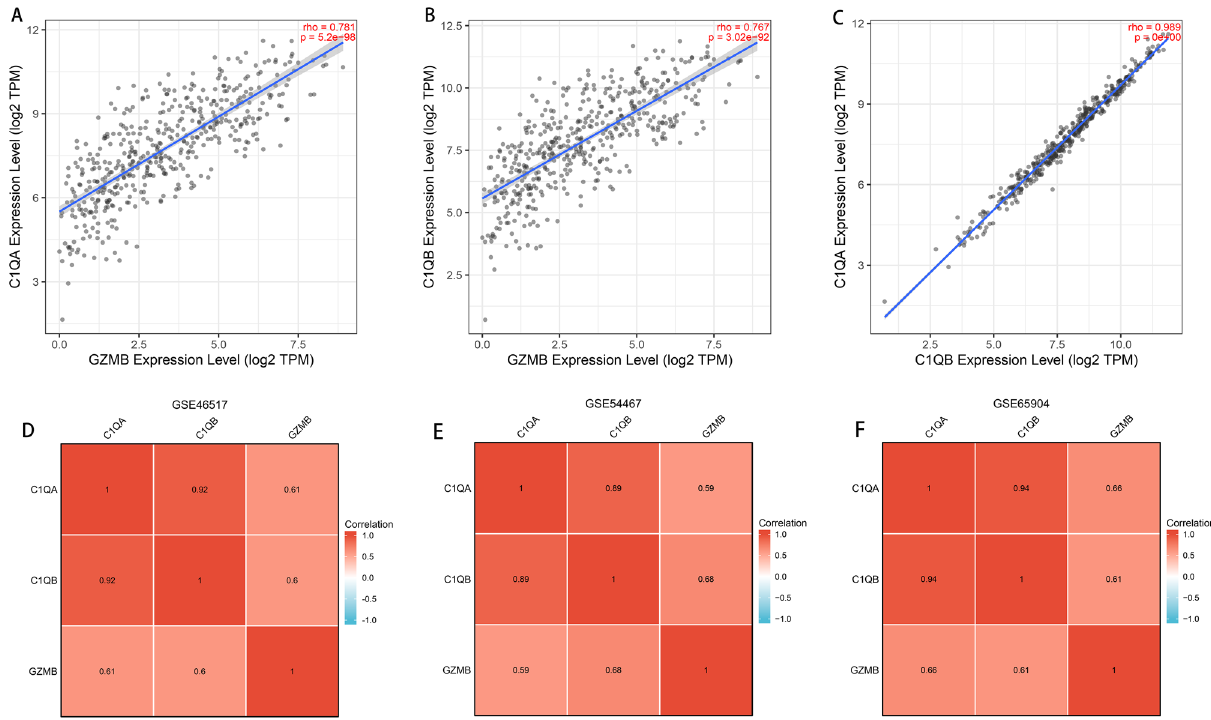
Figure 7. The correlations between expressions of C1QA , expressions of C1QB and expressions of GZMB in ( A – C ) TCGA, ( D ) GSE46517, ( E ) GSE54467, and ( F ) GSE65904. This figure was generated using the TIMER2.0 web tool (http:// timer. comp- genom ics. org/) 30 and “ggplot2” R